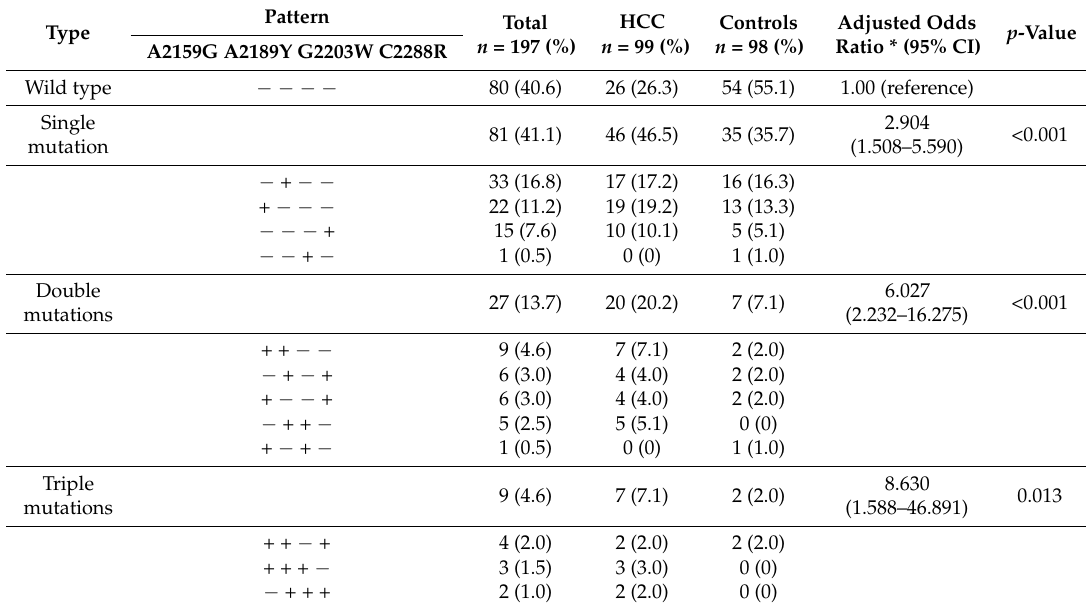
Table 5. Association between HCC and the presence of specific mutation patterns in the C